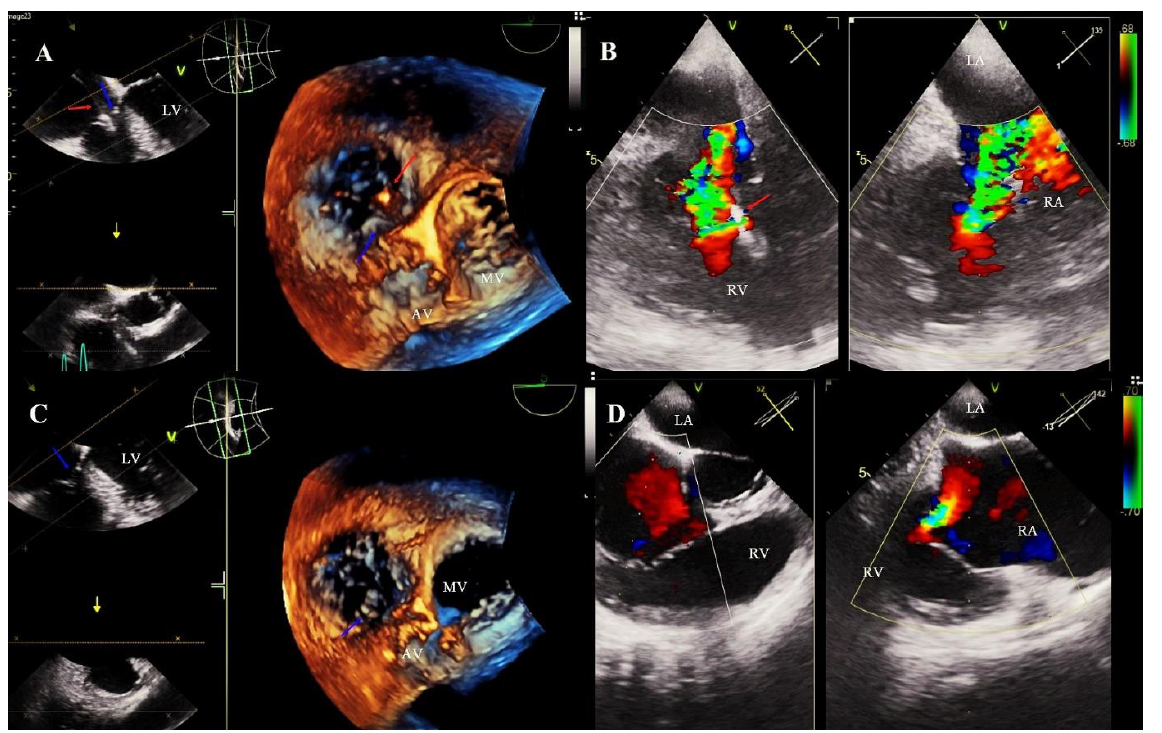
Figure 3. Tricuspid valve dysfunction with significant regurgitation as a result of an unfavorable interaction of the lead with the valve leaflet. Monitoring of the TLE procedure by TEE examination. ( A ): Septal leaflet is clamping down (blue arrow) by a ventricular lead (red arrow) with impaired coaptation of the tricuspid valve TEE 3D. ( B ): Severe tricuspid regurgitation as a consequence of pulling the leaflet. TEE 2D color Doppler valve. ( C ): Imaging after TLE. Improving the mobility of the septal leaflet and the coaptation zone (blue arrow). TEE 3D. ( D ): Significant improvement in the degree of valve regurgitation after extraction of the lead. TEE 2D.